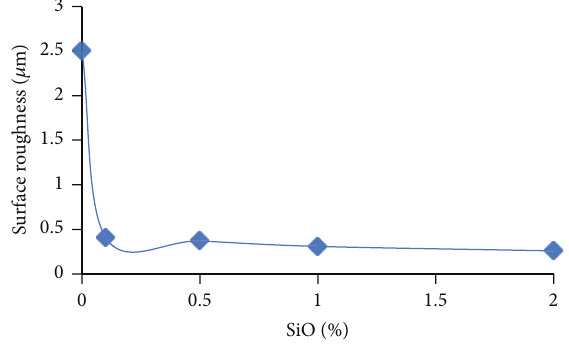
Figure 10: Variation in average surface roughness of EN-coatings as a function of SiO with surfactant (SLS) concentration in the EN